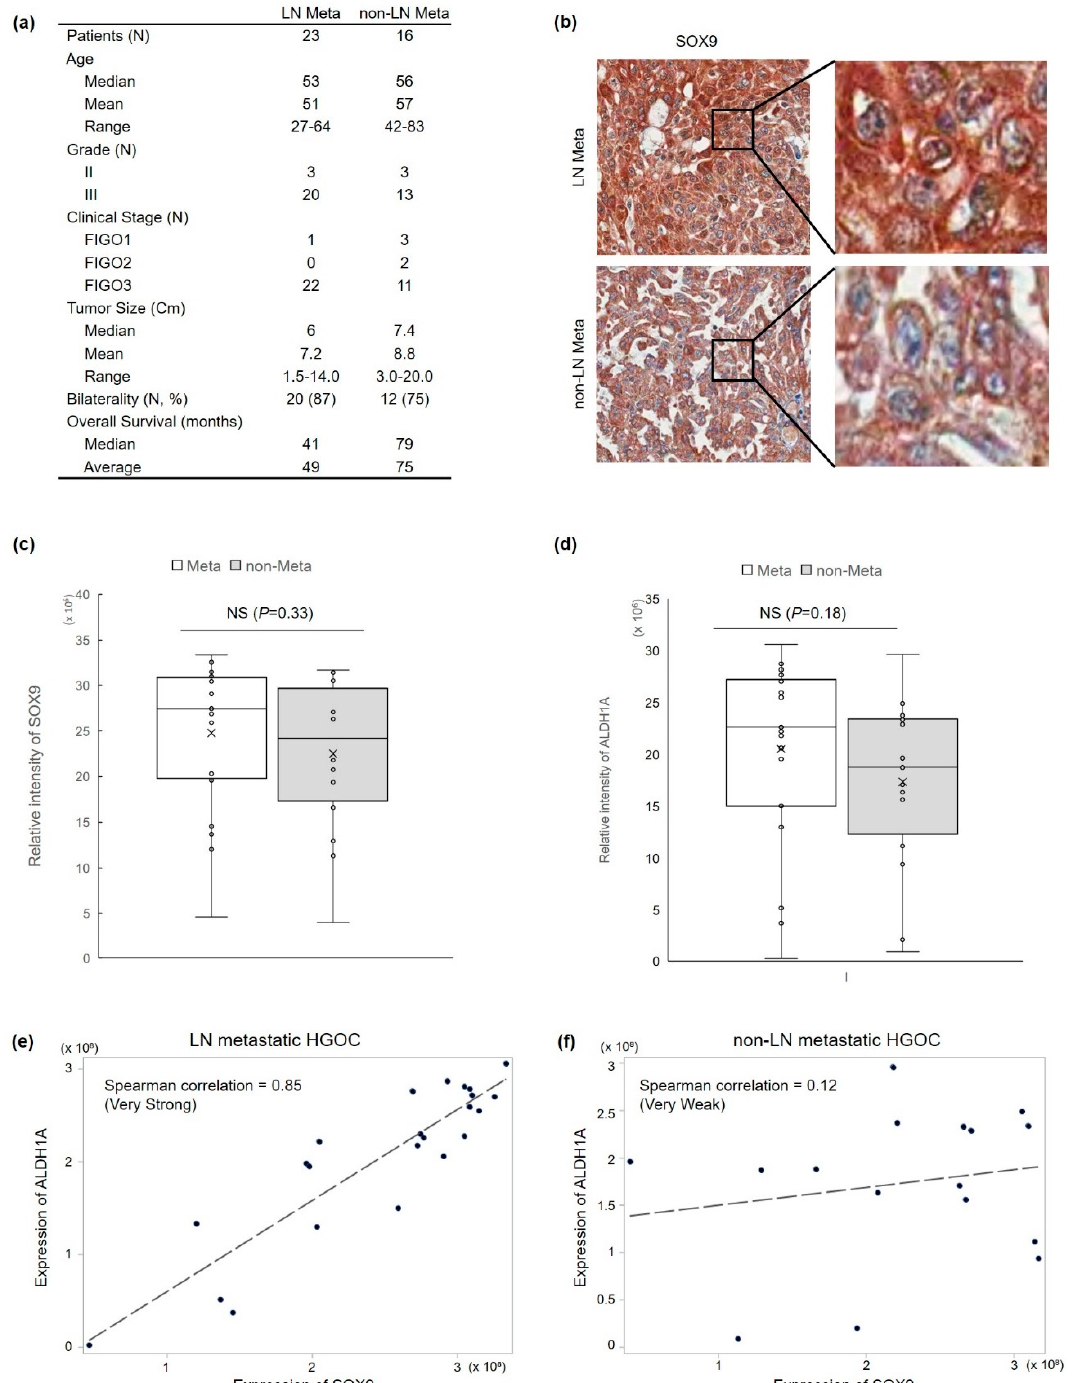
Figure 1. Overexpression of cytoplasmic-SOX9 and ALDH1 proteins in HGOC was associated with lymph node (LN) metastasis. ( a ) Clinical-pathological characteristics of ovary cancer specimens used in this study. ( b ) Representative images of immunohistochemical staining of SOX9 and ALDH1 pro- teins in HGOC. ( c , d ) Wilcoxon ranking sum analysis showed no significant (NS) association between LN metastasis and the expression level of SOX9 protein ( c ) or ALDH1 protein ( d ). ( e , f ) Spearman’s